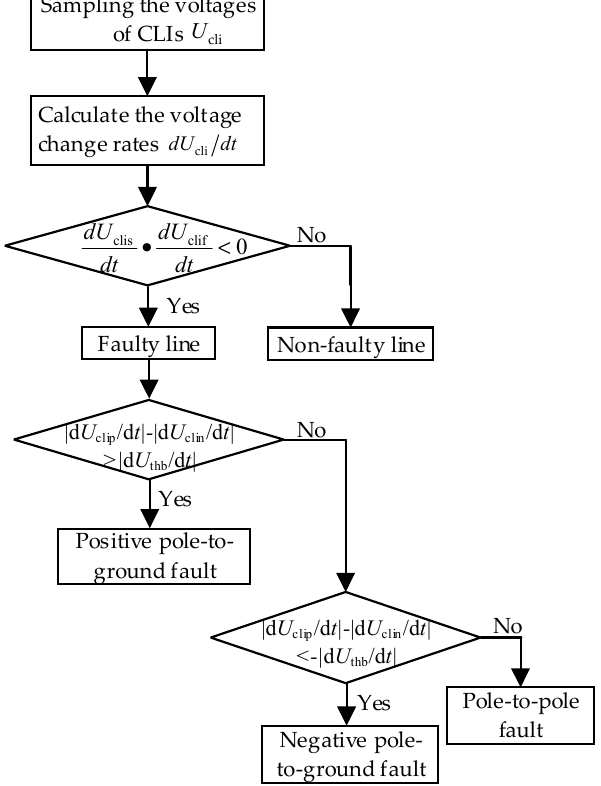
Figure 4. Flow chart of the proposed backup fault detection method for DC faults.